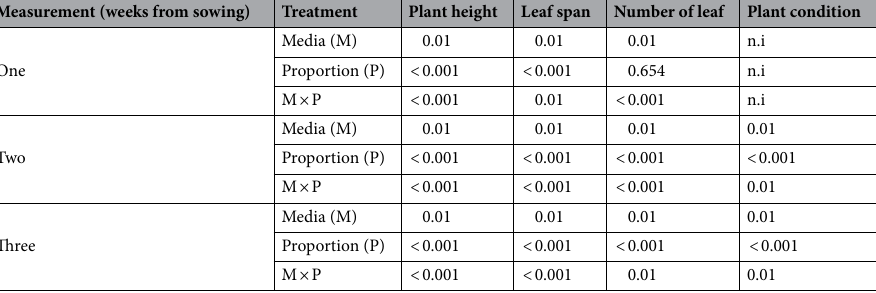
Table 5. Variance analysis for cucumber plant depending on factors (significance verified by the Duncan test). n.i., no identificated.